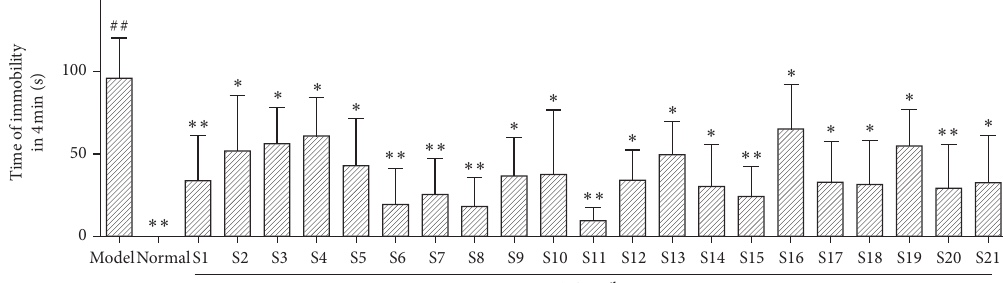
Figure 6: Results of forced swimming experiment of saponins in Glycyrrhiza uralensis Fisch. from 21 producing areas. The result represents means ± S.D. Note: Compared with the normal group ratio, ## P < 0 . 01 was an extremely significant difference. Compared with the model group, ∗ P < 0 . 05 means there is a significant difference, ∗∗ P < 0 . 01, with extremely significant difference ( n � 10). Table 4: Correlation between common peaks of saponins from Table 2: Correlation between the common peak of saponins from Glycyrrhiza uralensis Fisch. and forced Swimming Glycyrrhiza uralensis Fisch. and the effect of tonifying spleen and replenishing qi.